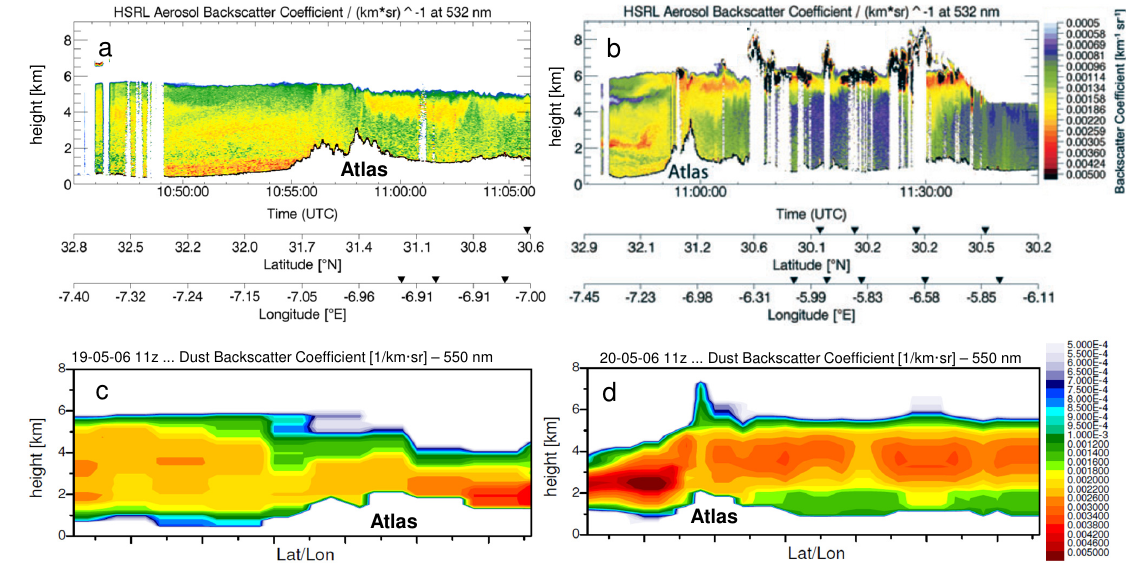
Fig. 13. Vertical cross-section of dust backscatter coefficient during the Falcon overflight from Casablanca to Ouarzazate on 19 and 20 May 2006. Lidar data from Falcon flight measurements (a, b) versus model-derived backscatter coefficient at 550nm (c, d) are shown. Arrows on the longitude/latitude axis indicate changes in the flight direction of the aircraft. The model coordinates (c, d) correspond with those from the